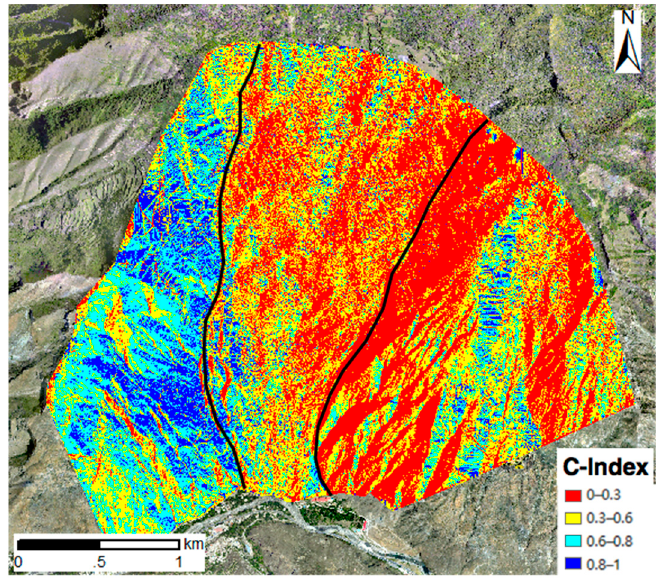
Figure 11. The C-index map of the Xishancun Landslide for the descending geometry.